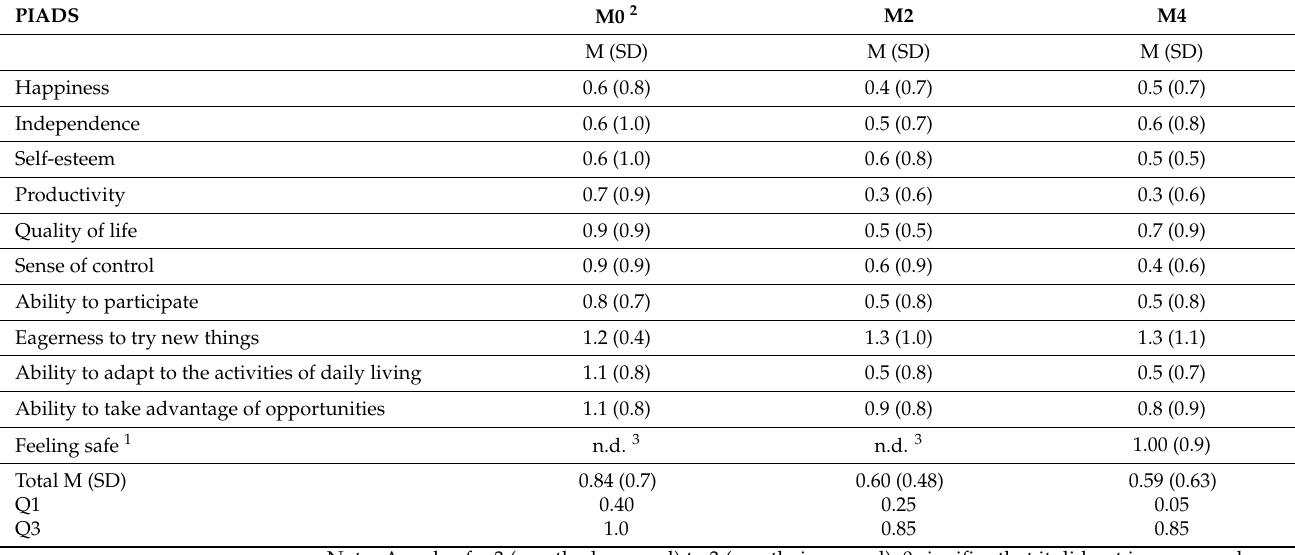
Table 5. Aspects of life for which PUs rated whether they were affected by the use of the ST at three time points (n =